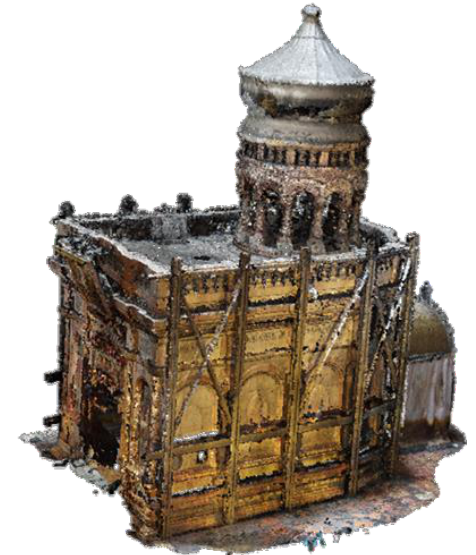
Figure 5: The coloured point cloud of the Holy